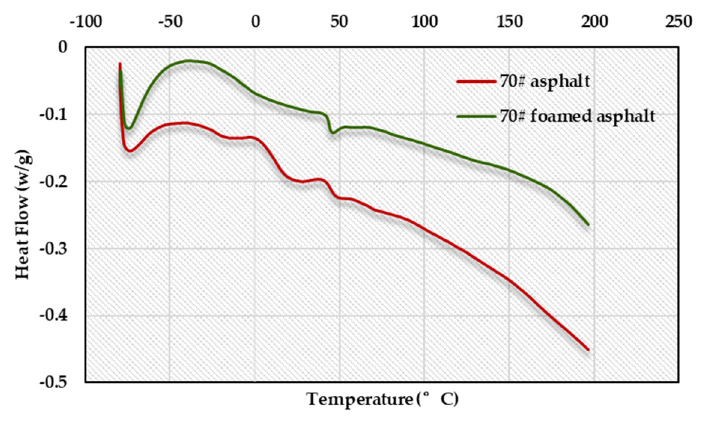
Figure 8. Differential scanning calorimetry (DSC) spectrum of 70# asphalt and 70# foamed asphalt. Four main parameters could be obtained from the DSC curve based on Origin Pro 9.1, including temperature range of endothermic peak, endothermic peak area, total endothermic peak area and endothermic peak height. The endothermic peak data of base asphalt and foamed asphalt are summarized in Table 4.